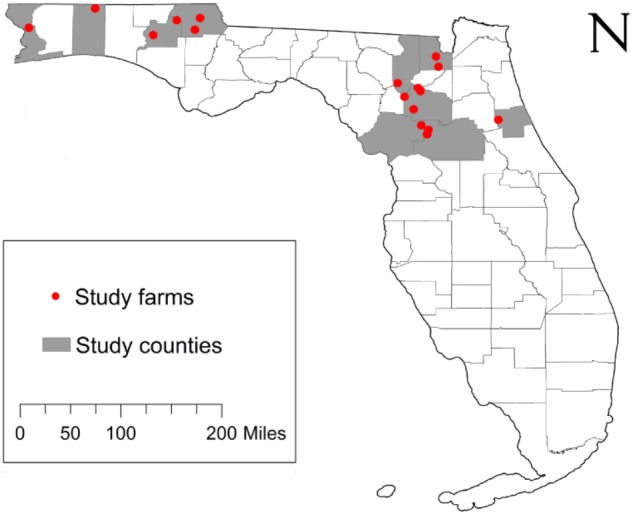
Study location and sample origin. The study enrollment locations included 17 farms from 9 counties across North and Central Florida, United States. The farms appear (red circles) relative the state and county boundaries of Florida.